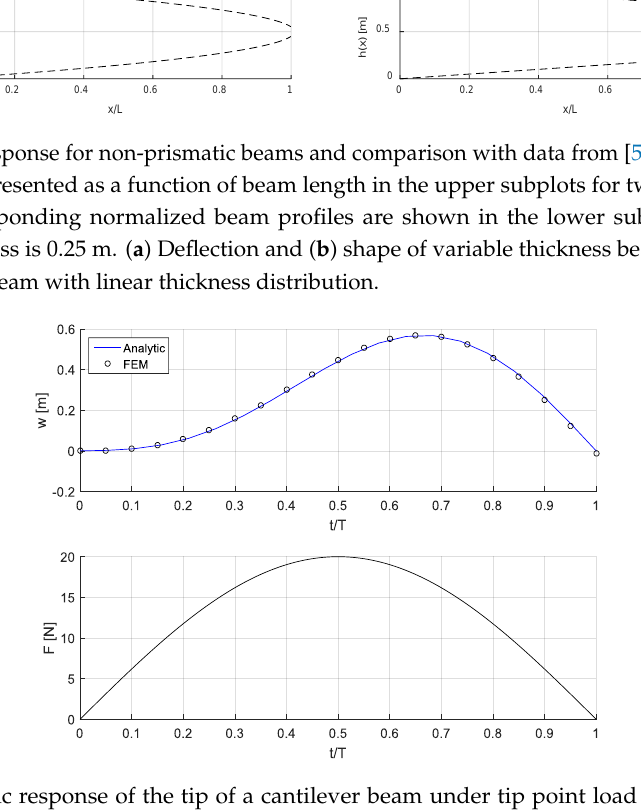
Figure 5. Dynamic response of the tip of a cantilever beam under tip point load for one period of motion and comparison against the analytic solution. Data from Warburton [52]. ( a ) Deflection, ( b ) tip loading of the beam.